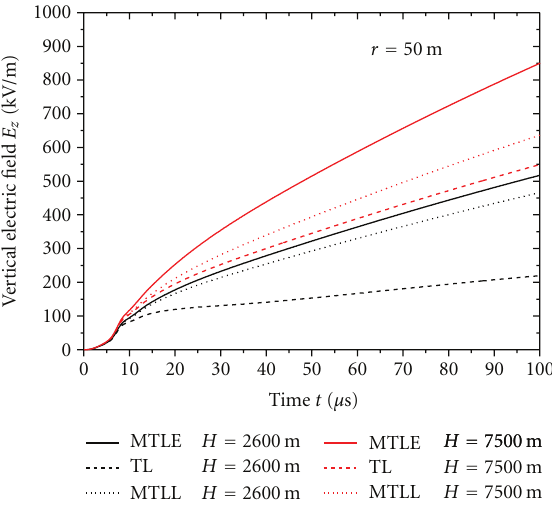
Figure 5: Vertical electric field at 5km from the channel base for NCBC, three di ff erent models and two channel heights ( H = 2600 m and 7500 m).